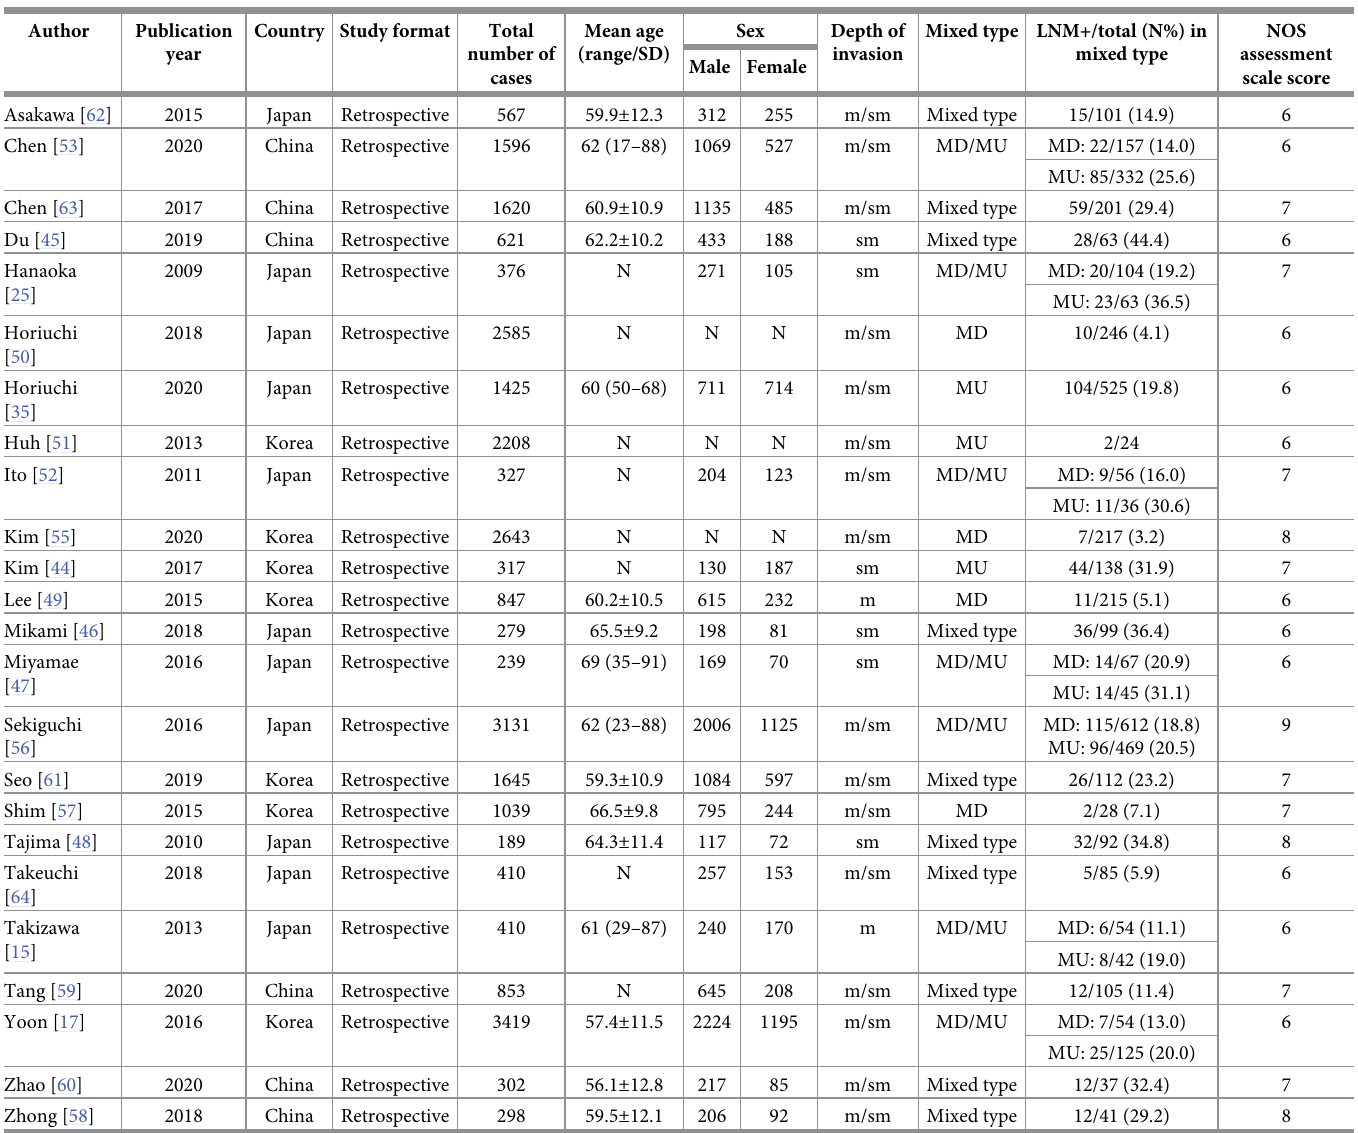
Table 1. Characteristics of included